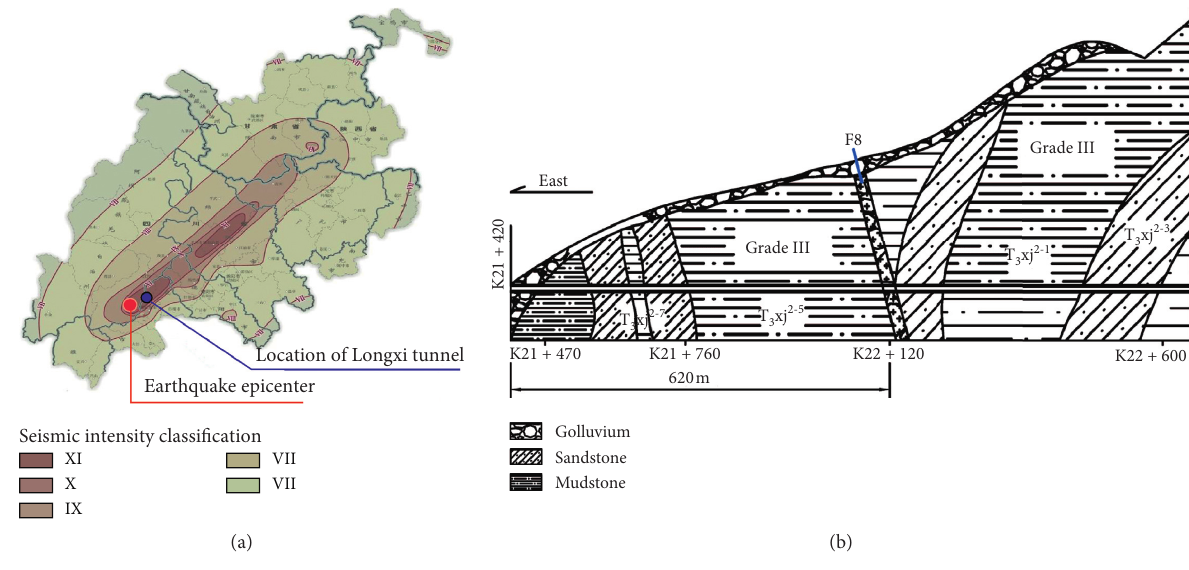
Figure 2: (a) Location and (b) profile diagram of Longxi